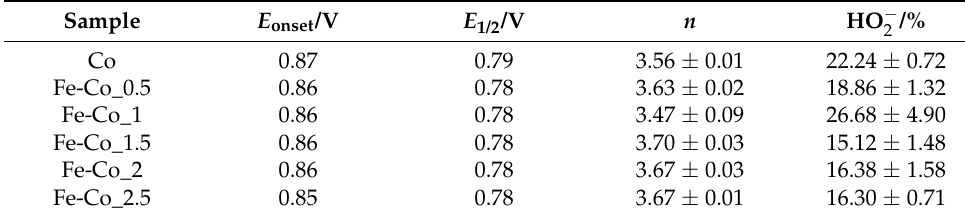
Table 4. Electrocatalytic properties of the Fe-Co oxides active phase deposited on the N,S-MPC support, compared with the spinel Co/N,S-MPC. The average number of the transferred electrons and the formed HO − intermediates were determined by the RRDE method, in the potential range of 2 0.1–0.5 V. Sample E onset /V E 1/2 /V n HO −